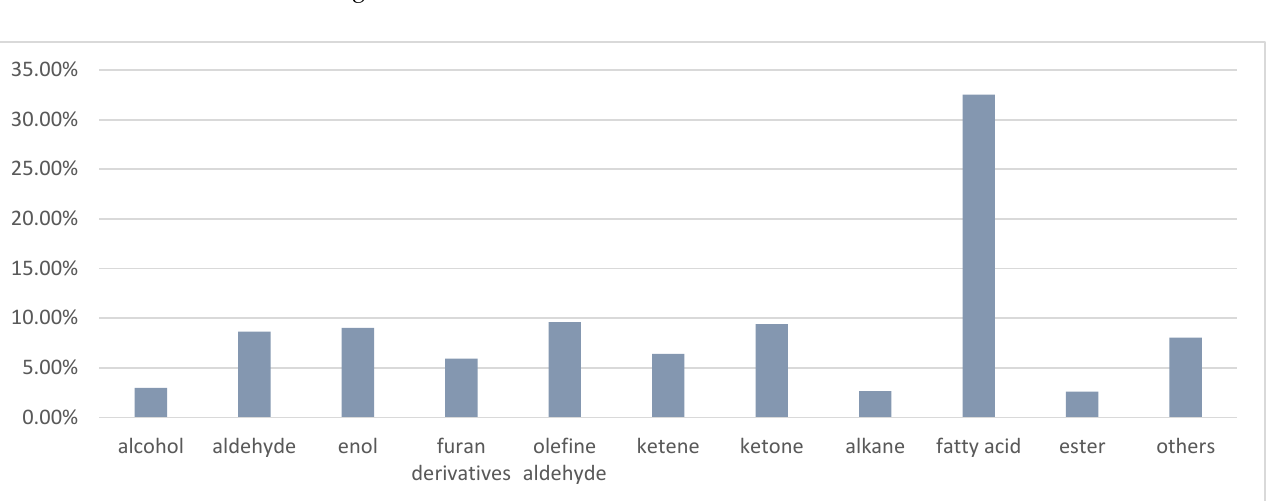
The predominance of palmitic acid signifies that the oil was of palmitic acid chemotype,